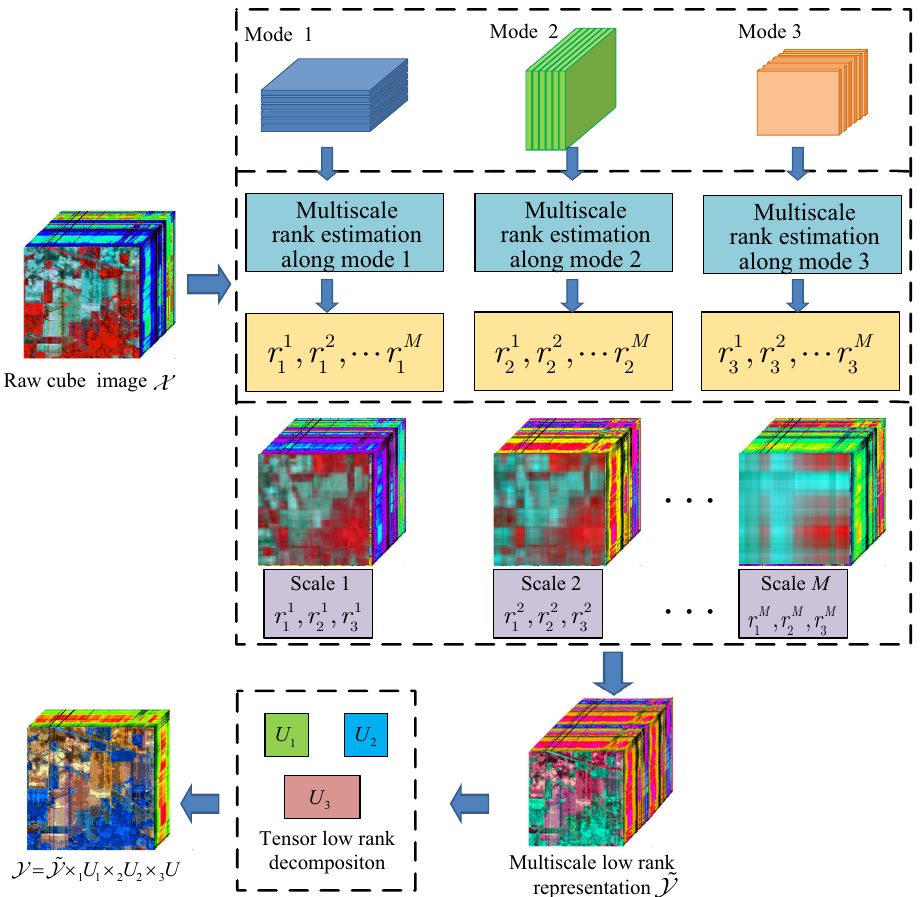
Figure 1. The schematic illustration of T-MLRD.The proposed T-MLRD consists of four steps: (1) estimate the optimal rank for each mode of the raw hyperspectral image according to the specified N-scale threshold values. (2) Construct the single low rank representation associated to the optimal rank of scale N. (3) Fuse the different scale representation tensor low rank decomposition